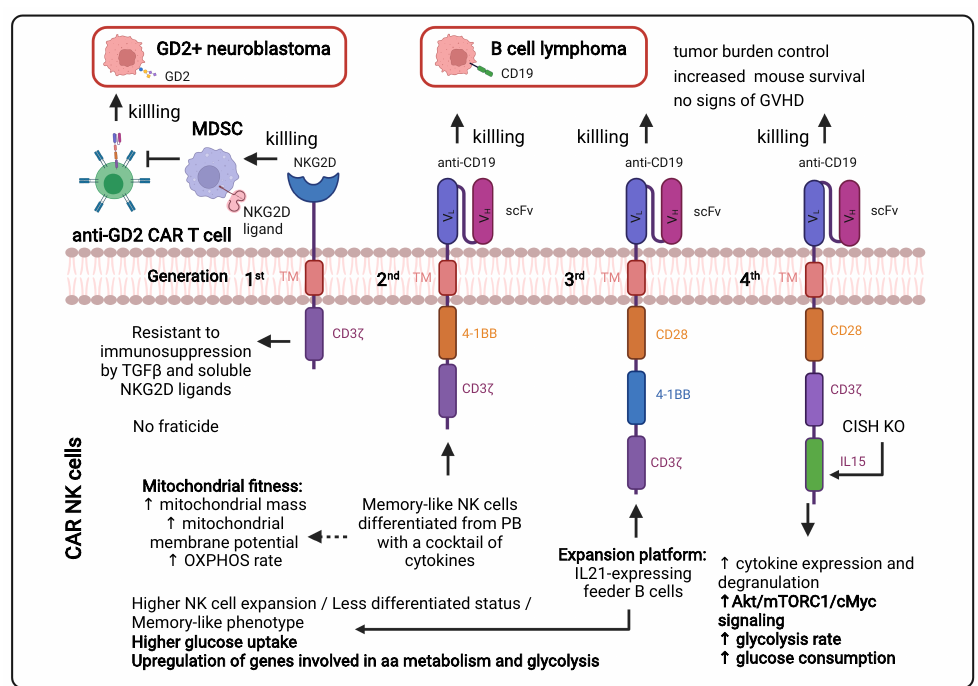
Figure 6. Overview of CAR NK cell generations. Depicted designs are representative of CAR NK cells resistant to challenges within the tumor microenvironment that limit NK cell metabolism and CAR NK cells with reported improvement of metabolic features. MDSCs, myeloid-derived suppressor cells; TGF β , transforming growth factor β ; tCD19, truncated CD19; GVHD, graft-versus-host disease; OXPHOS, oxidative phosphorylation; aa, amino acid. Figure generated by Biorender.com (accessed on 15 November